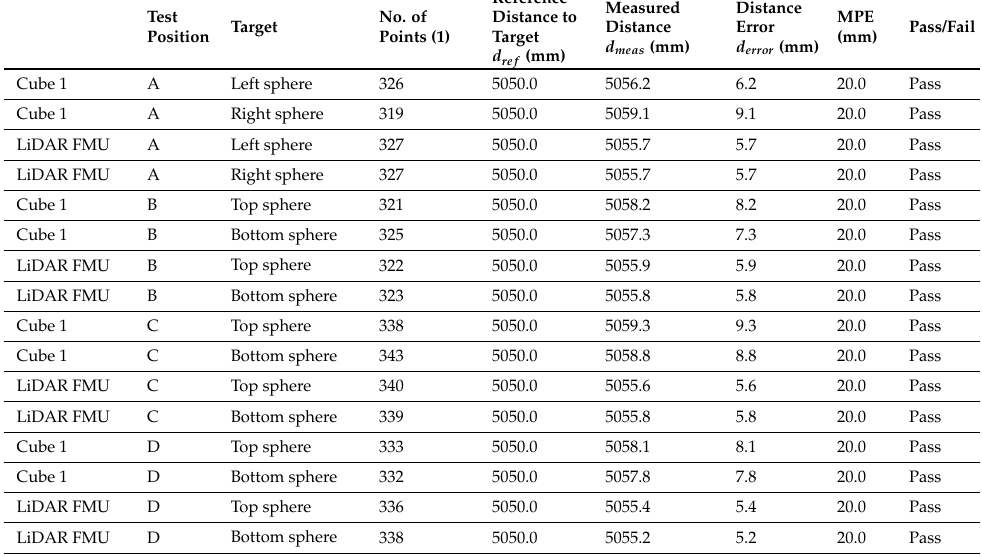
Table 4. Results of symmetric